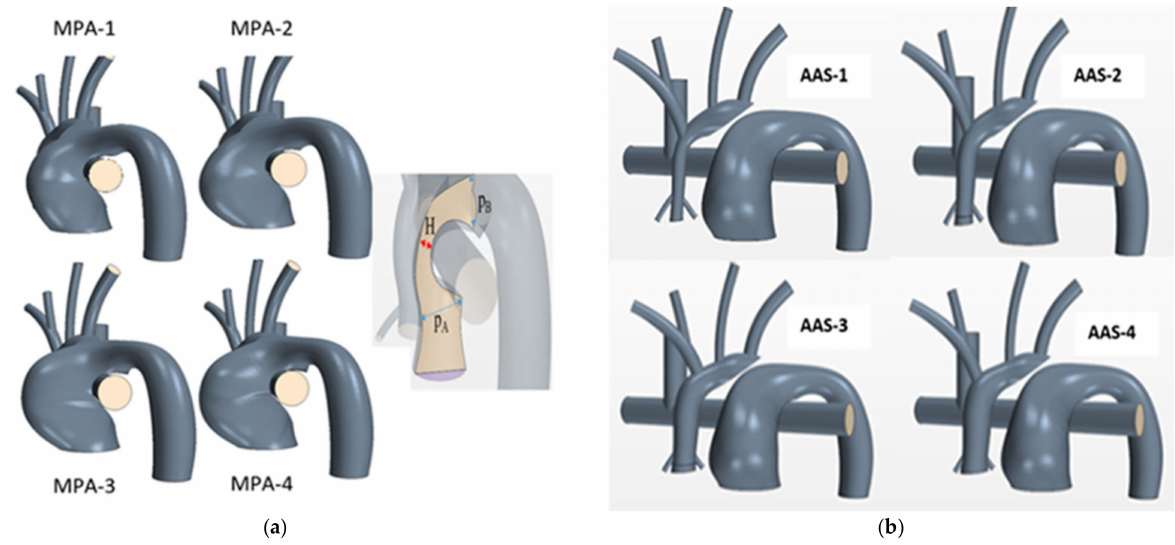
Figure 3. Patient generic synthetic geometries for varying ( a ) MPA narrowing denoted as H, and ( b ) ascending aorta root diameters ( D AA